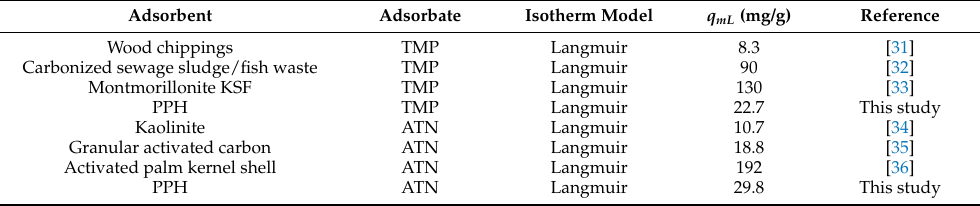
Table 3. Comparison of maximum adsorption capacities for TMP or ATN with various adsorbates at neutral pH and